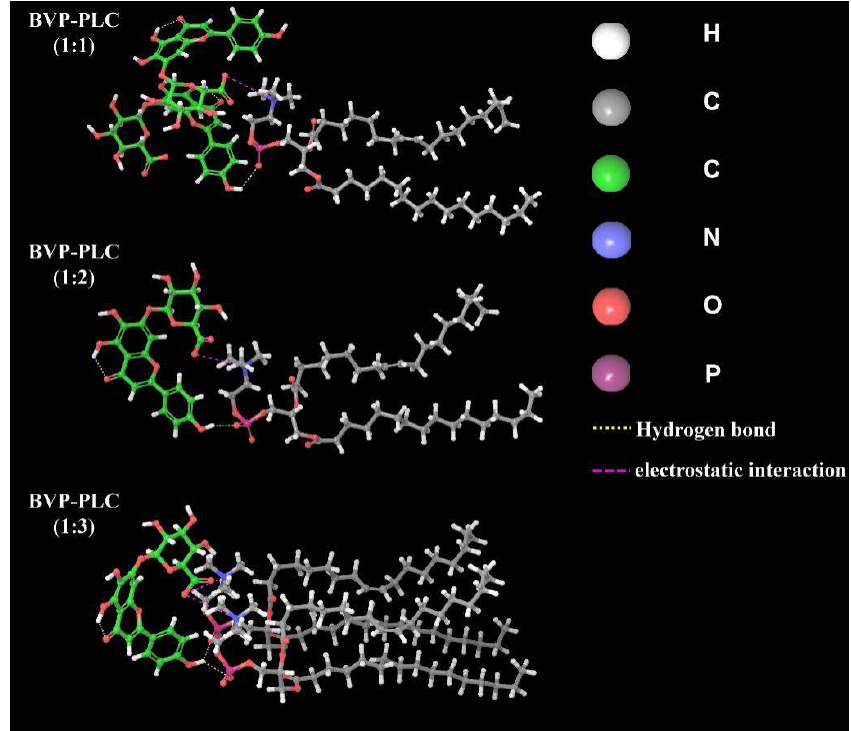
Figure 6. Interaction between drugs and phospholipids in BVP-PLC with different drug-lipid ratios.